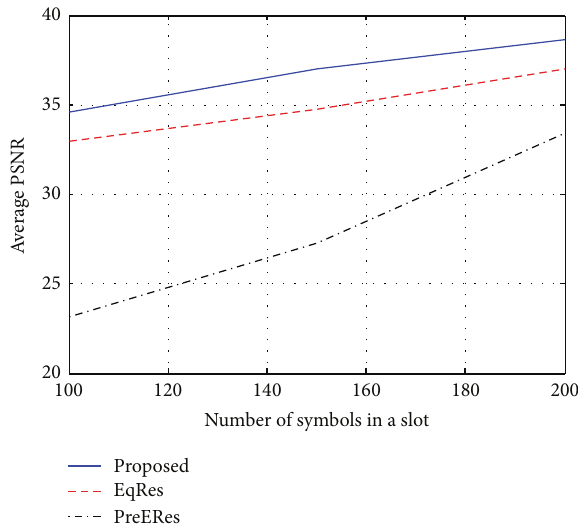
Figure 4: Comparison of the performance of different frameworks in terms of the number of symbols in a slot.